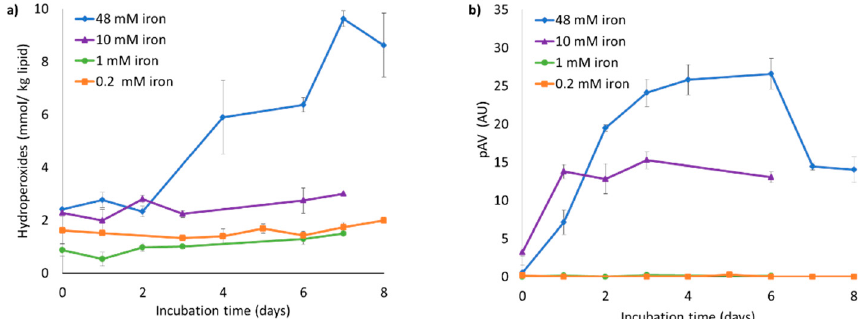
Figure 4. ( a ) Hydroperoxide concentration and ( b ) para-anisidine value (pAV) of iron-loaded lipo- some suspensions containing 0.2, 1, 10, or 48 mM iron, for a fixed PC concentration. All liposome suspensions were incubated at 40 °C under slow rotative agitation. Error bars represent standard deviations (n = 4).